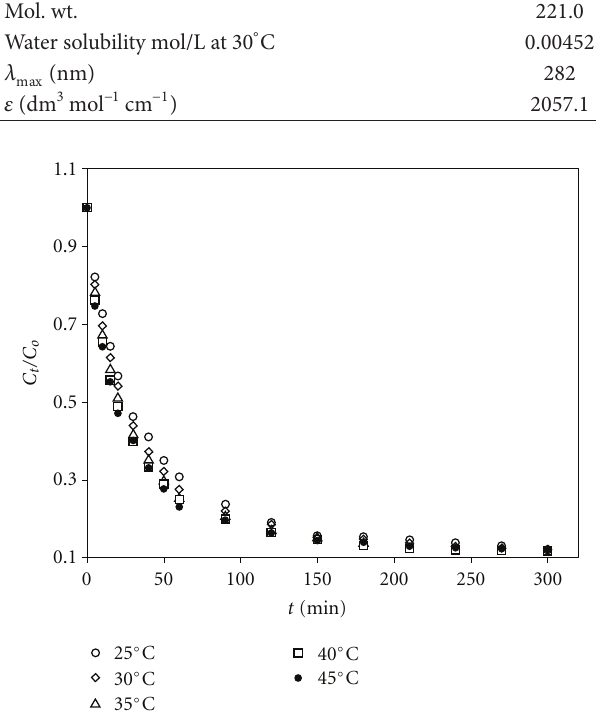
F 2: Adsorption kinetics of 2, 4-D at different temperatures.